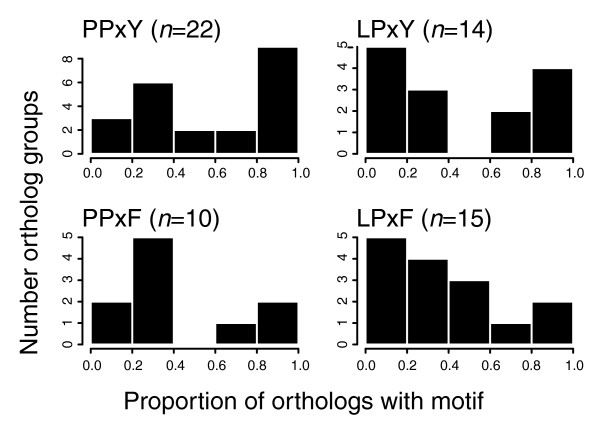
Histograms representing the levels of conservation for the PPxY, PPxF, LPxY and LPxF motifs among 54 orthologous protein sets.